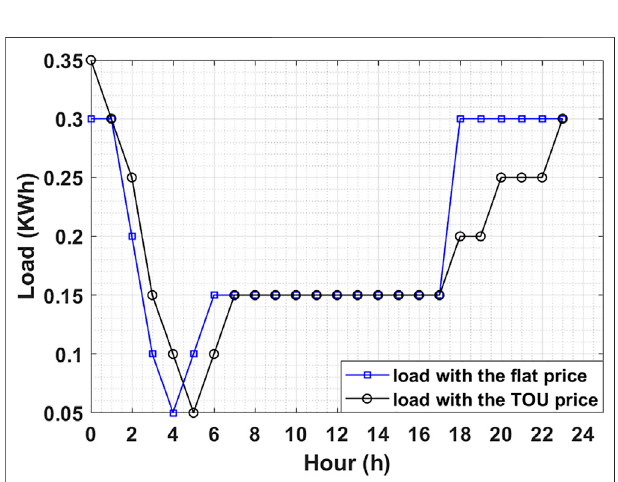
FIGURE 7 | Load of illustration between the fl at price and TOU